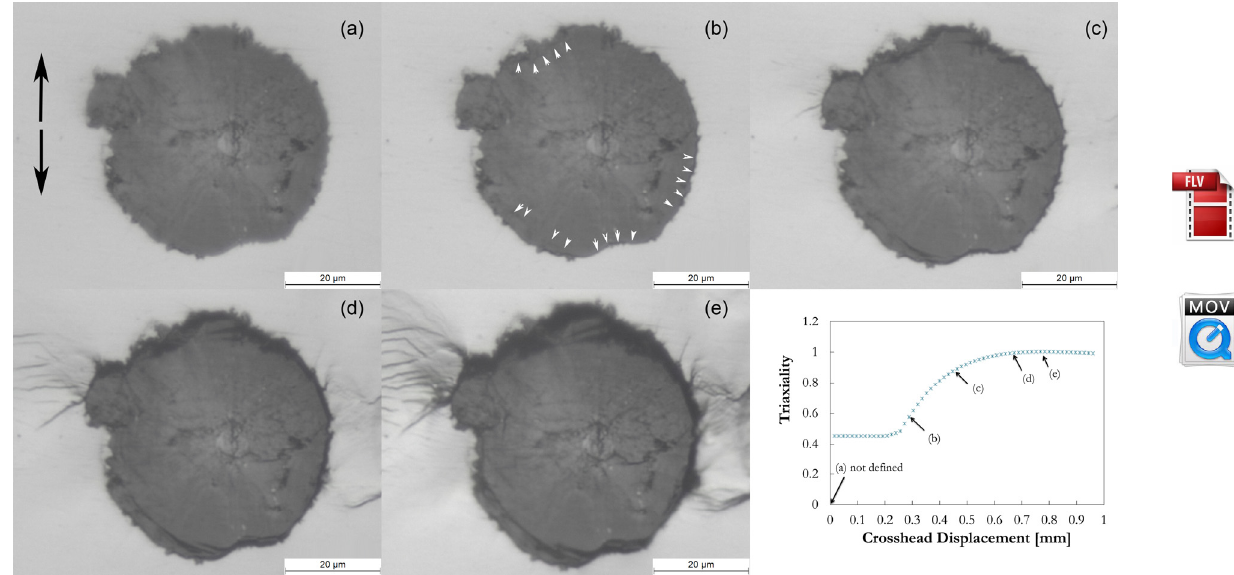
Figure 7: EN GJS700-2 ductile cast iron (Nodule 1, Fig. 5 and 6). Digital Microscope in situ lateral surface analysis performed on notched specimen (a-e); black arrows show the loading direction. Diagram: Triaxiality Factor - Crosshead displacement evolution.